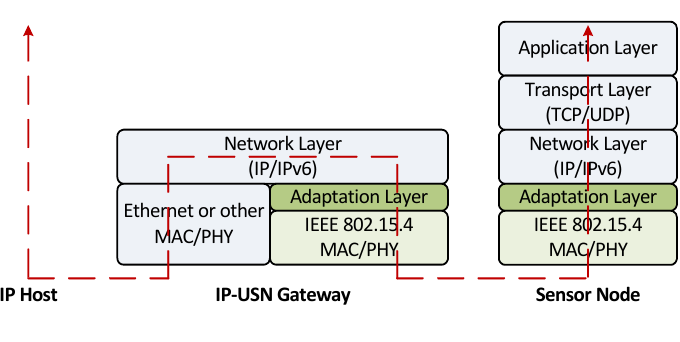
Figure 1. Traffic flow in